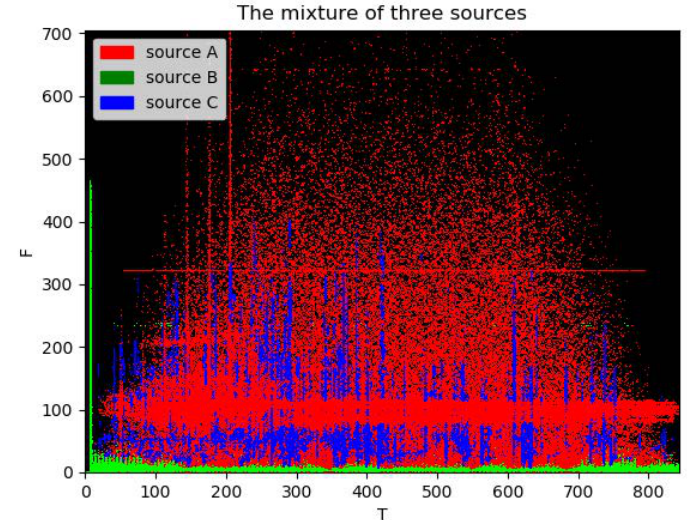
Figure 10. Separation results for three-source